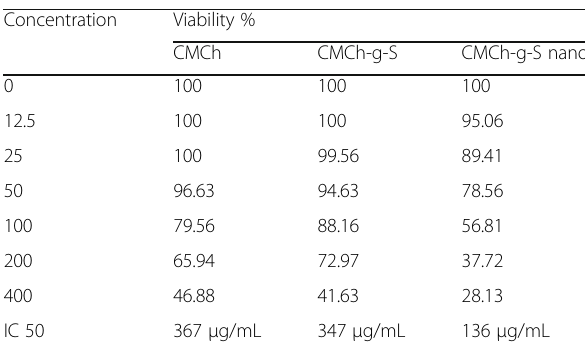
Table 3 Cytotoxicity effect of CMCh, CMCh-g-S and